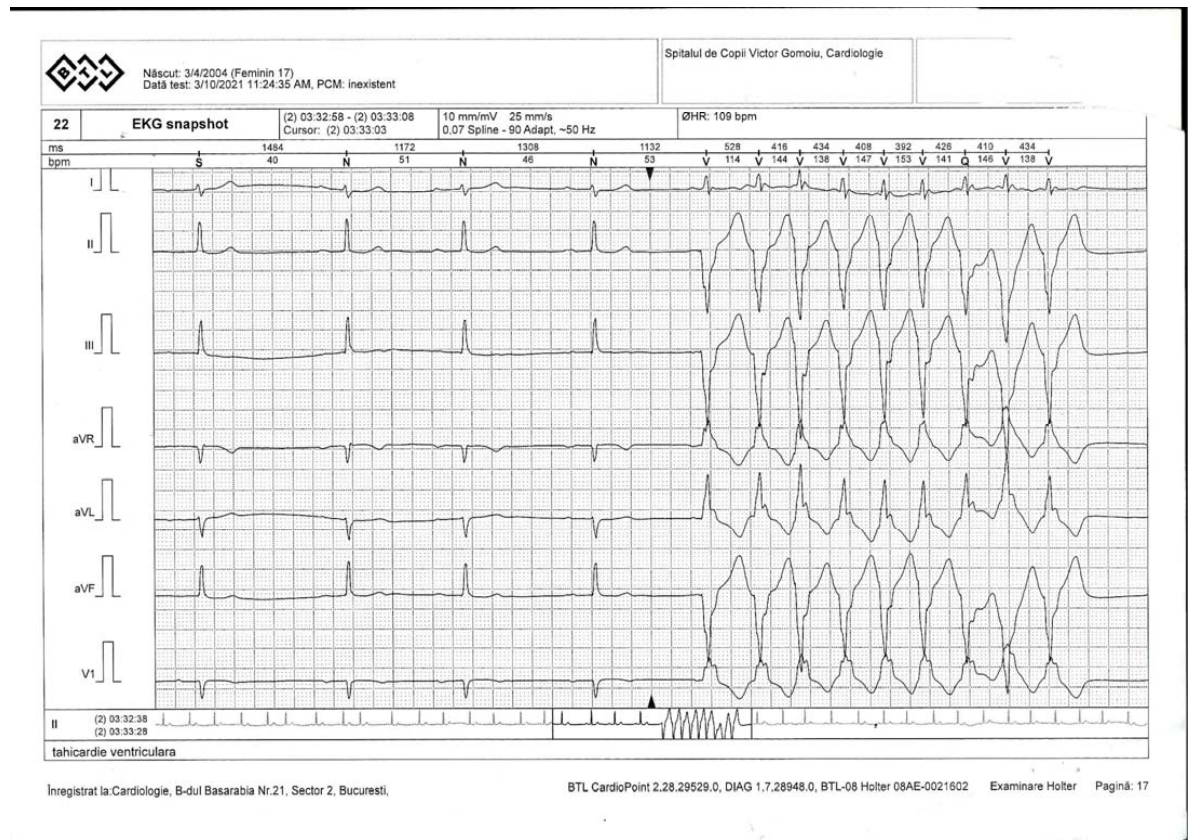
Figure 2. Ventricular tachycardia.